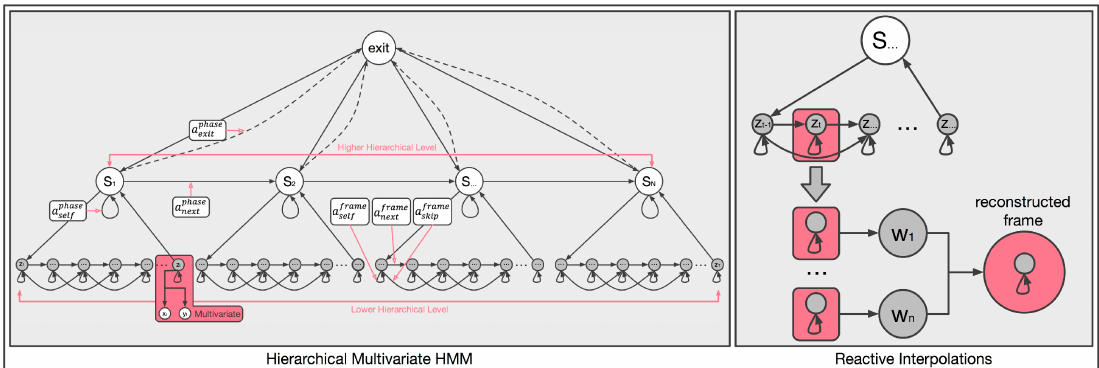
Figure 5. Representation of the constructed hierarchical multivariate hidden Markov model (HMM) with the reactive interpolations.